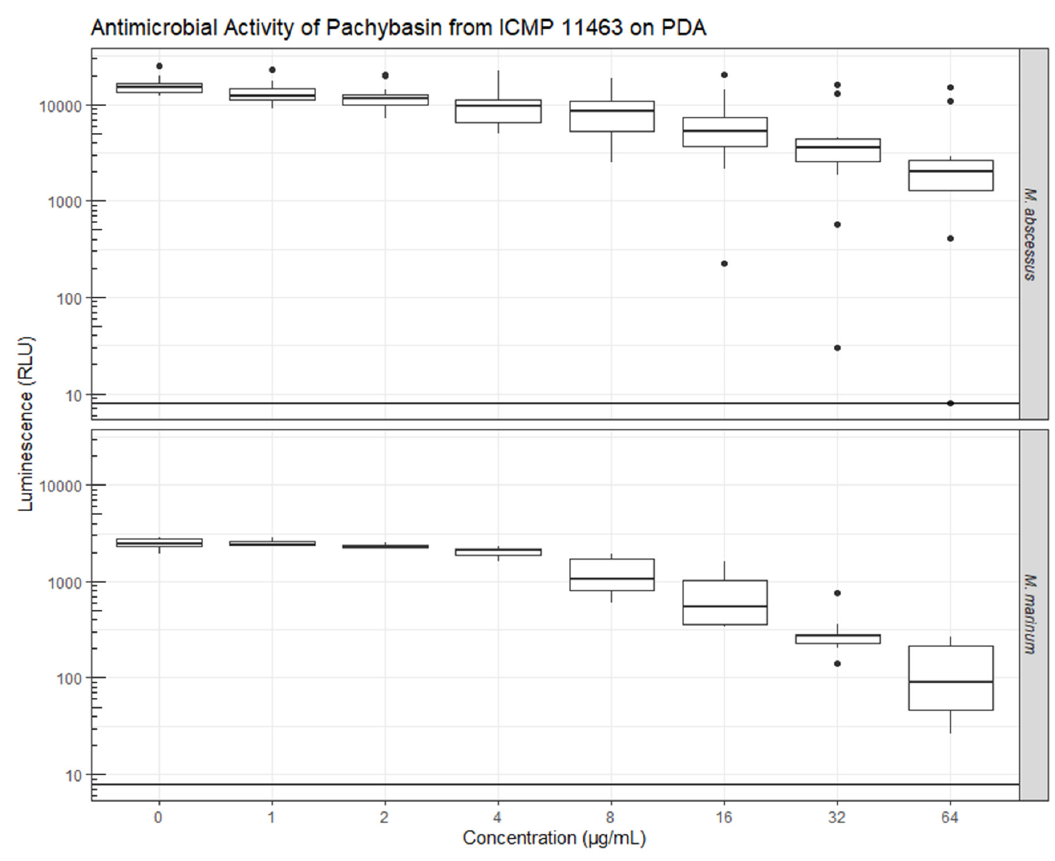
Figure 5. Antimicrobial activity of 5 against M. abscessus and M. marinum. The raw data (Supplementary Materials II) has been deposited online on Figshare.com (doi:10.17608/k6.auckland.14503584).